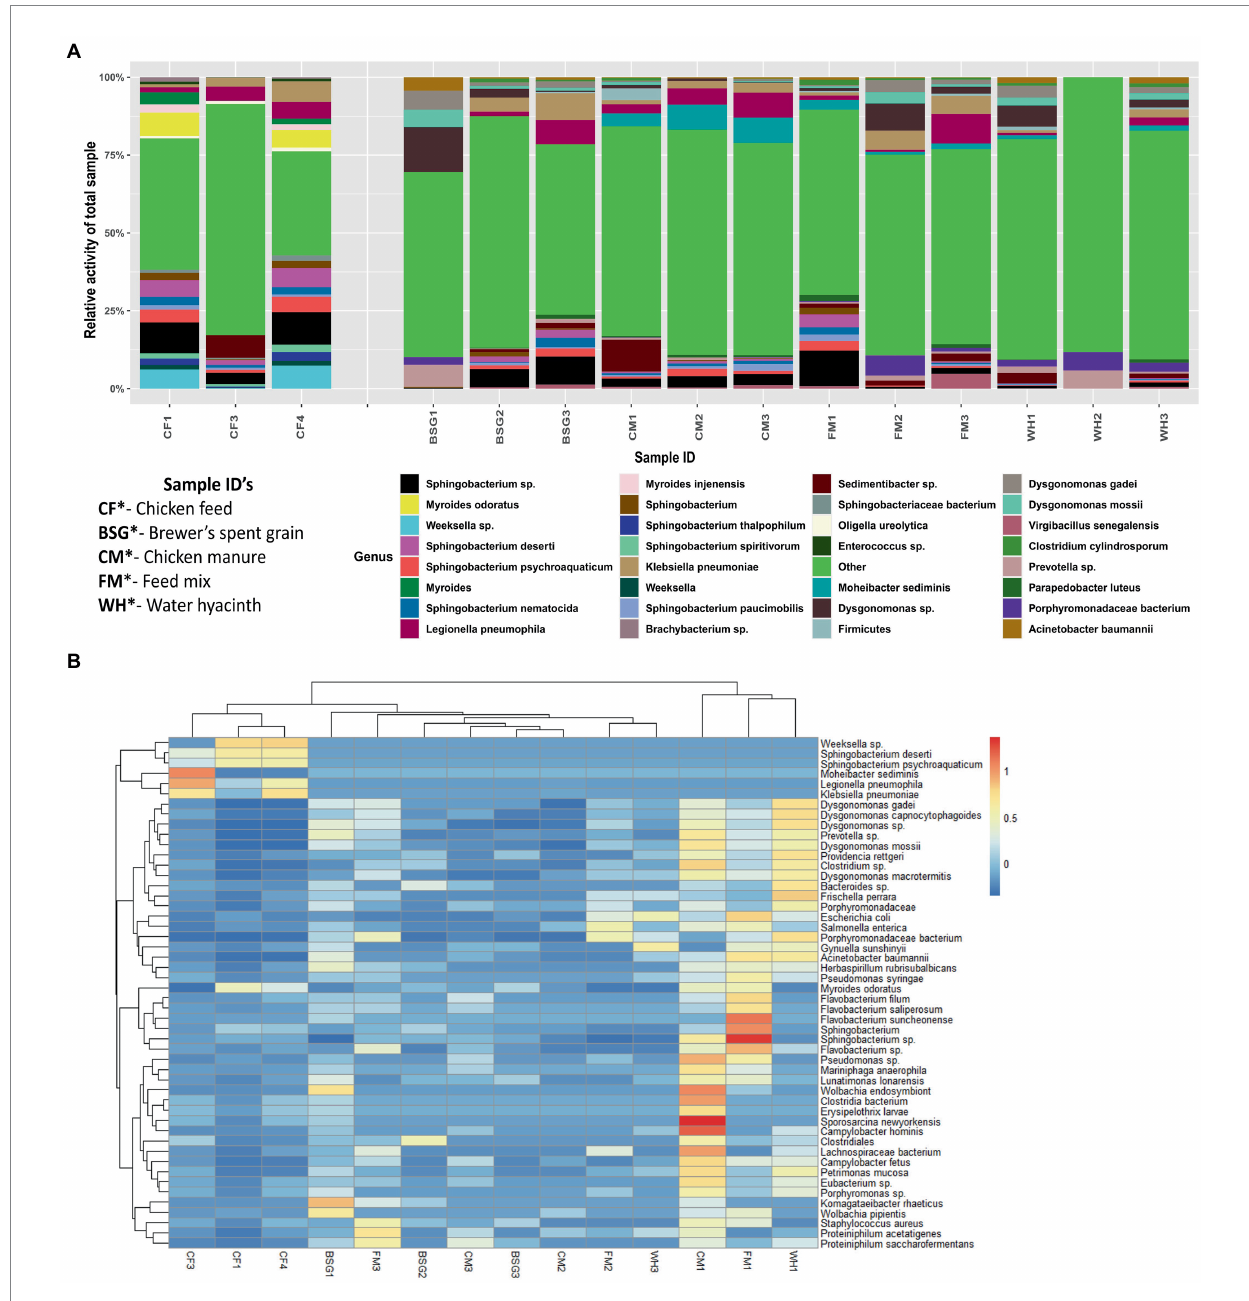
FIGURE 4 The relative activity (A) of various microorganisms and dissimilarity (B) between the individual